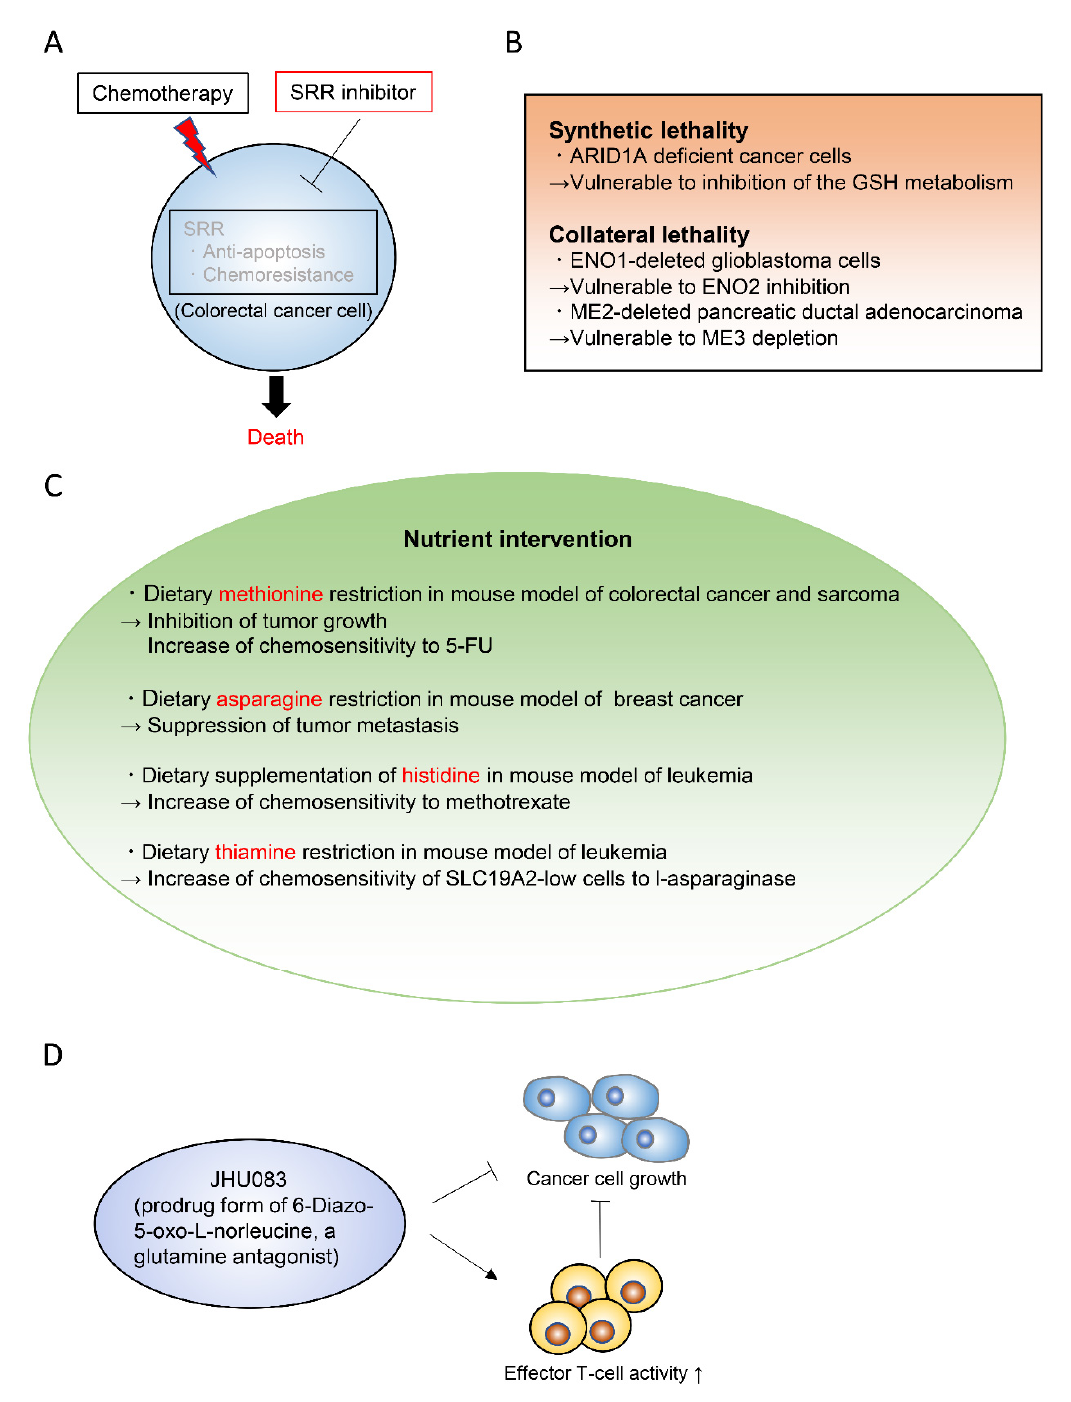
Figure 7. Emerging therapeutic strategies to target cancer metabolism. ( A ). Inhibition of serine racemase (SRR) augments the efficacy of chemotherapy [156]. ( B ). Synthetic lethality and collateral lethality are emerging strategies to target cancer metabolism. ( C ). Nutritional interventions that selectively remove or supply particular nutrients could suppress tumor growth or enhance chemosensitivity. ( D ). JHU083 differentially modulate the metabolism of cancer cells and anti-tumor immune cells, which can synergistically enhance the anti-tumor effects [170]. SRR; serine racemase, ARID1A; AT-rich interactive domain-containing protein 1A, GSH; glutathione-SH, ENO; Enolase, ME; malic enzyme, 5-FU; 5-fluorouracil, SLC; solute carrier.